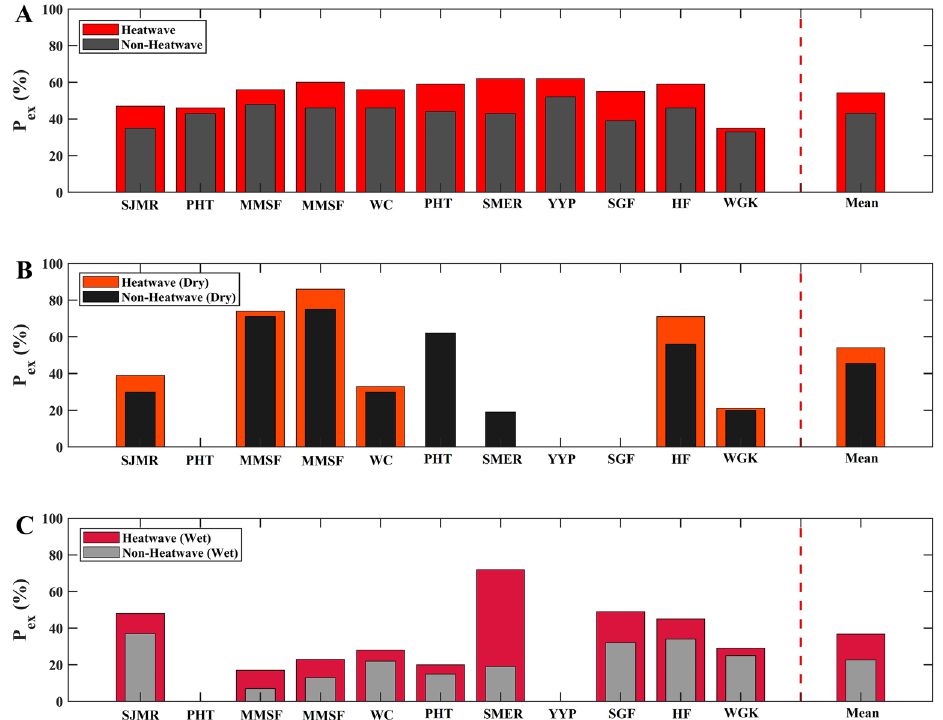
Figure 4. P ex (%) indicates the corresponding exceedance likelihoods when exceeding its average soil respiration rate. The mean (right side beyond the dashed red lines) represents the average P ex (%) of all eleven study sites. ( A ) P ex (%) indicates soil respiration given heatwave and non-heatwave. ( B ) and ( C ) represents P ex (%) of soil respiration given heatwave and non-heatwave and two soil moisture regimes (i.e., dry and wet condition), respectively. Due to insufficient data points at a given soil moisture regime (e.g., SMER, PHT, and SGF), the P ex (%) have been excluded. The PHT and YPP study areas are not shown since soil moisture data was not available. In addition, the SGF study site displayed only measurement during the winter period; therefore, dry condition data was not